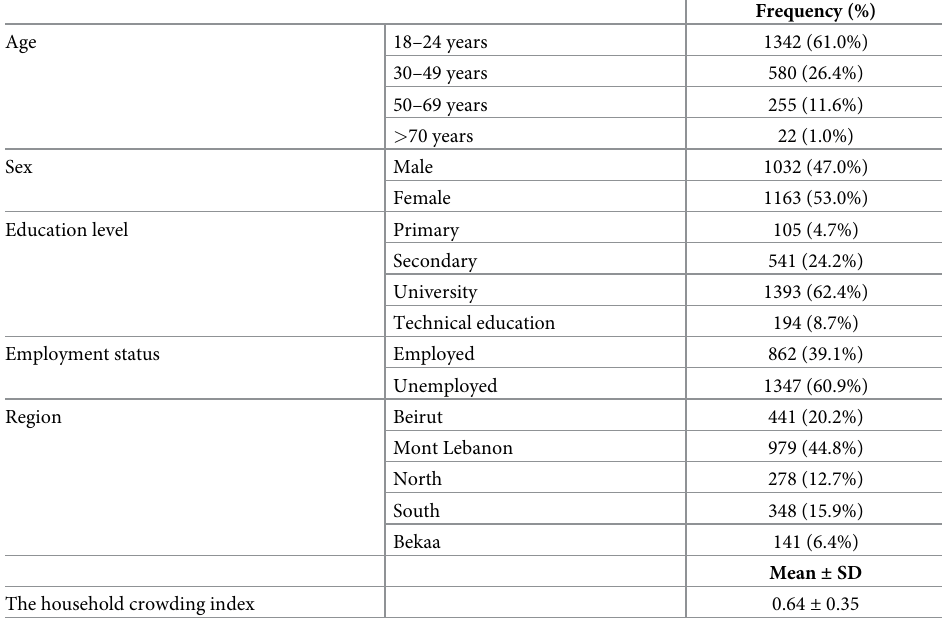
Table 1. Sociodemographic characteristics of the